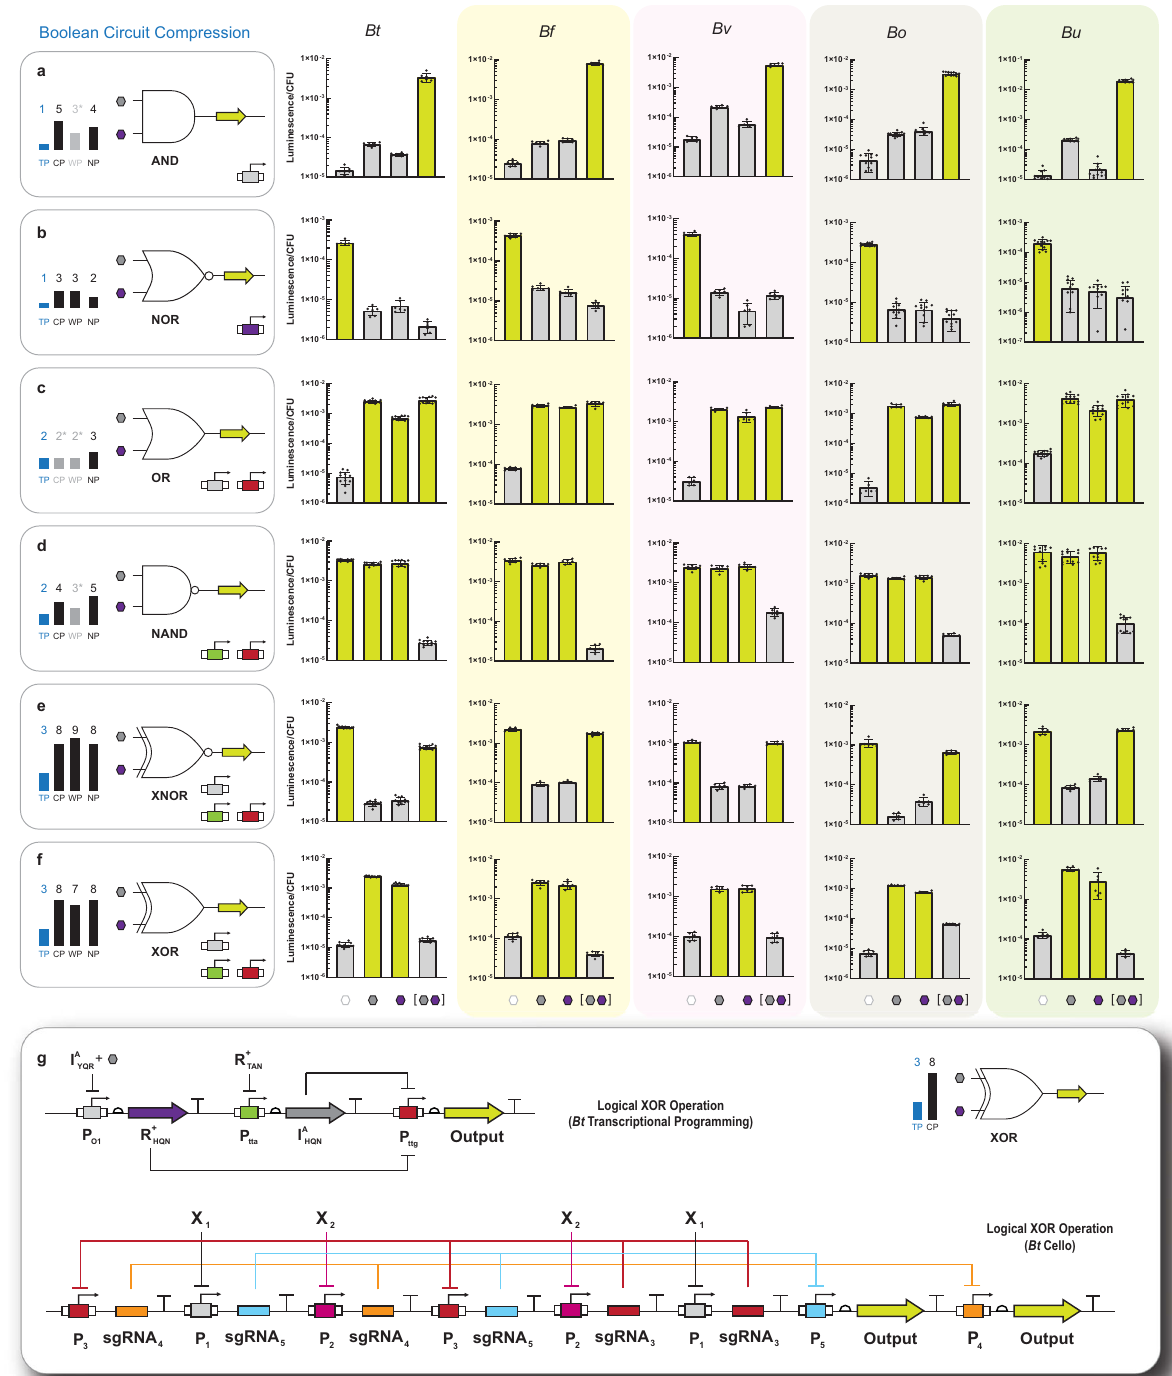
Fig. 3 Logic gates and circuit compression in fi ve Bacteroides species. a Degree of AND gate circuit compression compared to published circuits (left) along with AND gate performance in fi ve Bacteroides species (right). Degree of circuit compression is represented by the number of regulated promoters required to construct the logic gate (TP transcriptional programming, CP Cello programming, WP multicellular wires programming, NP Boolean NOR programming). Note, the gray and ( * ) bars in the circuit compression summaries indicate an apparent or ad hoc gate. Strains harboring circuits were grown in the presence of all combinations of both inducers (each at a fi nal concentration of 10 mM) and assayed for luciferase activity (Methods). b NOR gate compression and performance in fi ve Bacteroides . c OR gate compression and performance in fi ve Bacteroides (see Supplementary Fig. 8g for corresponding genetic architecture). d NAND gate compression and performance in fi ve Bacteroides (see Supplementary Fig. 8h for corresponding genetic architecture). e XNOR gate compression and performance in fi ve Bacteroides (see Supplementary Fig. 8l for corresponding genetic architecture). f XOR gate compression and performance in fi ve Bacteroides . g Wiring diagram for XOR construction using transcriptional programming (top) compared to Bt Cello programming (bottom). Regulated promoters used for each logic gate are shown in the bottom right corner of each left-hand box (also see Fig. 1 for more detail). Source data are provided as a Source Data fi le. Data represent the average of n = 6 biological replicates. Error bars correspond to the SEM of these